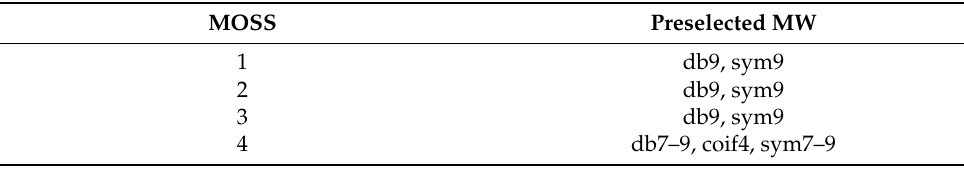
Table 4. Mother wavelets preselected with the 2% criterion for each MOSS.